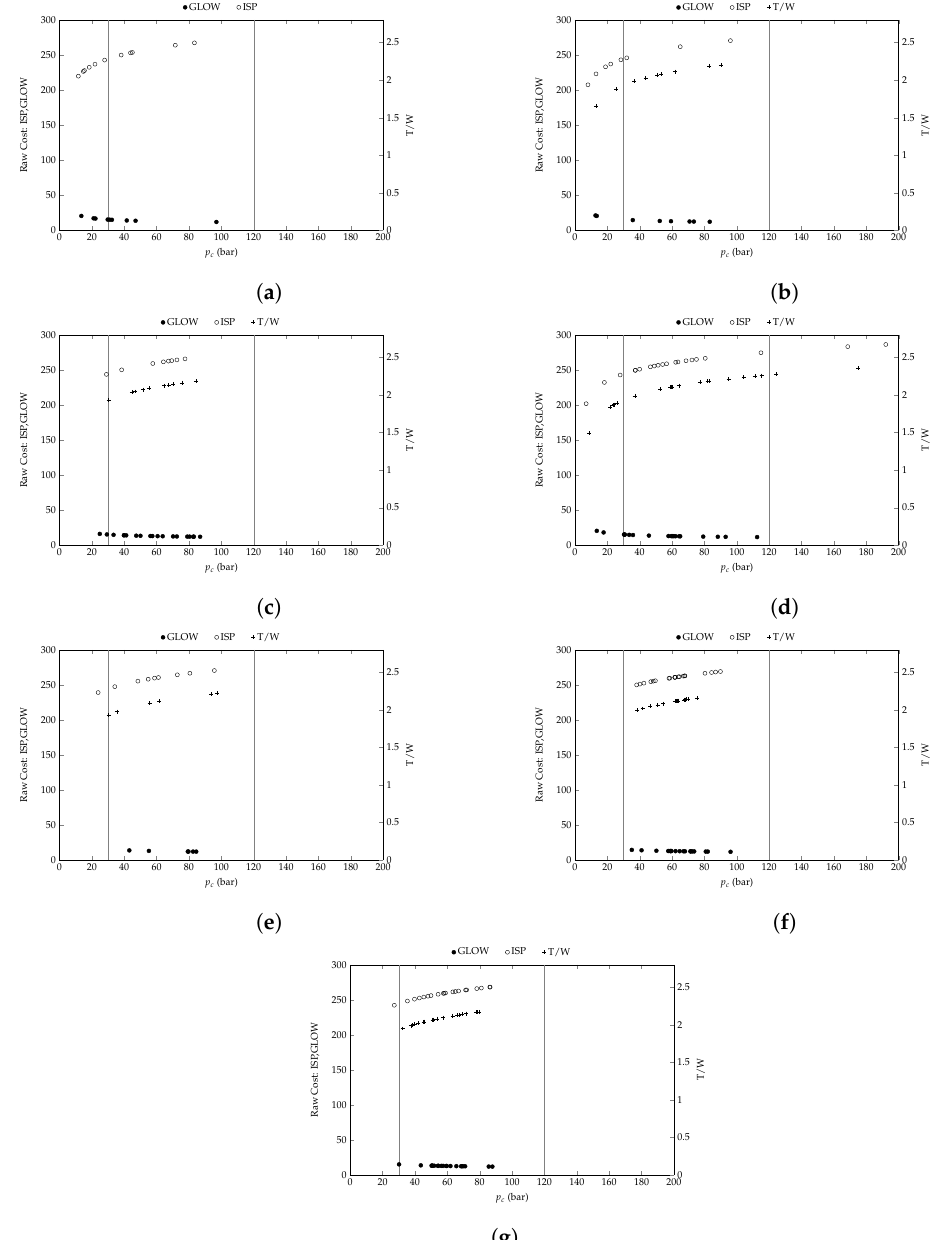
Figure 4. Optimization results for the GG Cycle with mission ∆ V = 3800 m/s and H = 120 km using all 7 techniques and 3 OFs. ( a ) Nelder Mead (NM). ( b ) Simulated Annealing (SA). ( c ) Cuckoo Search Algorithm (CSA). ( d ) Particle Swarm Optimization (PSO). ( e ) Pigeon-Inspired Optimization (PIO). ( f ) Genetic Algorithm (GA). ( g )